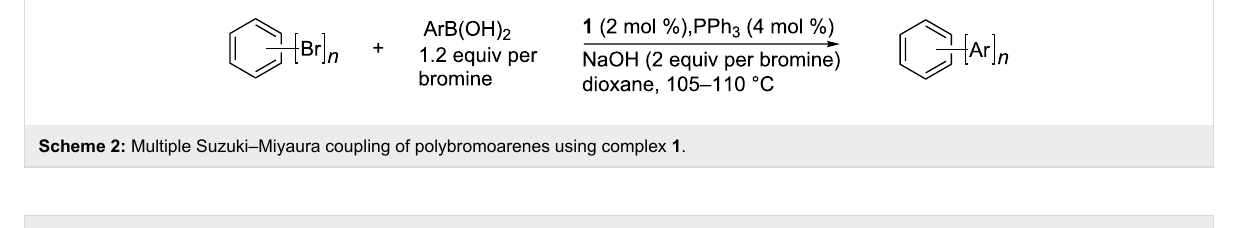
Table 1: Multiple Suzuki–Miyaura coupling of polybromoarenes with arylboronic acids by using complex 1 a .